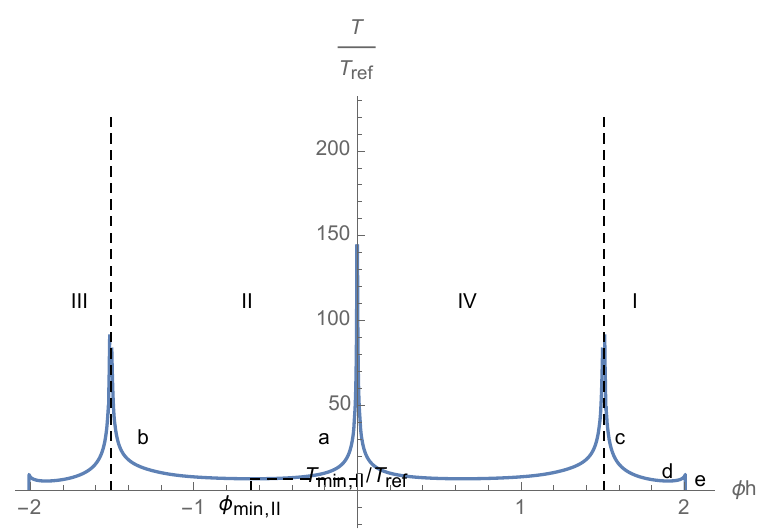
Figure 21 . T as a function of (cid:30) h for a particular choice of the reference scale T ref